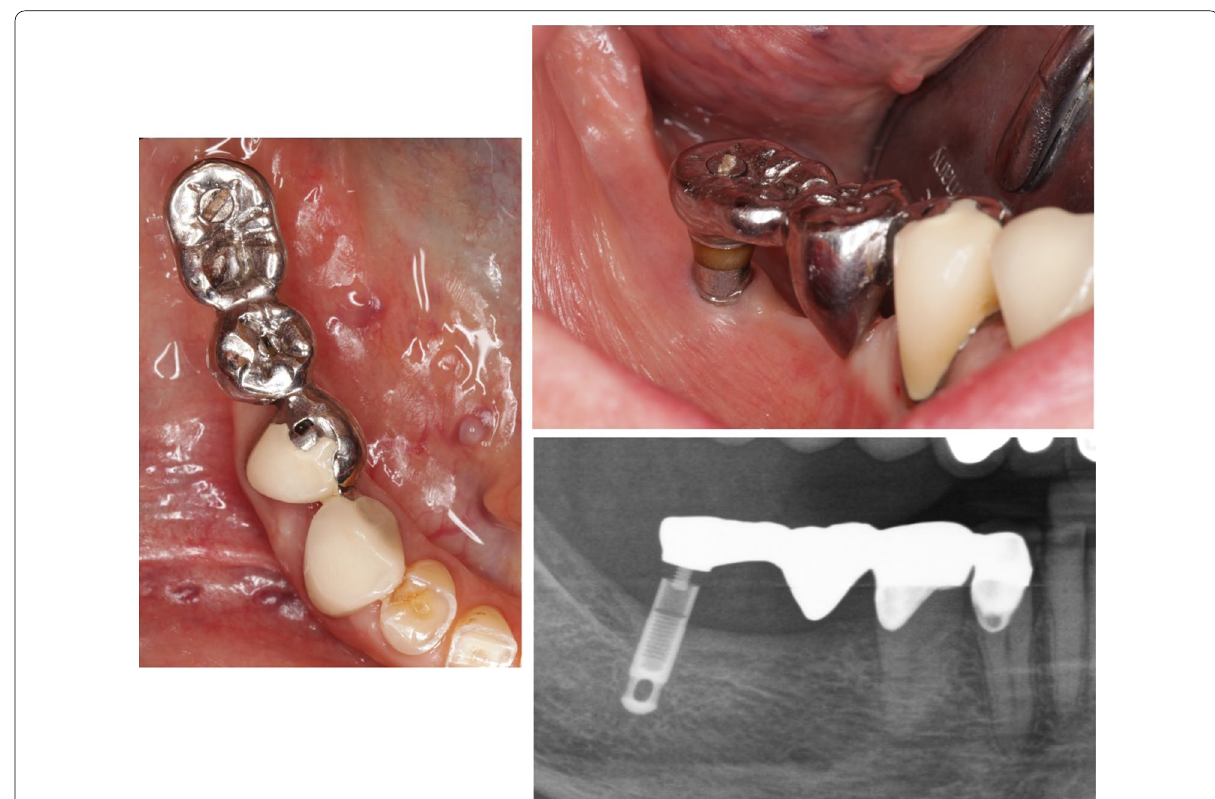
Fig. 1 Clinical photographs and radiograph of a combined tooth–implant retained fixed partial denture in clinical examination group (CEG) after 26 years in situ. Note the radiolucent intramobile element (IME) between the IMZ implant and the superstructure as well as the transmucosal implant extension (TIE), which can be distinguished from the implant itself by a subtle radiolucent